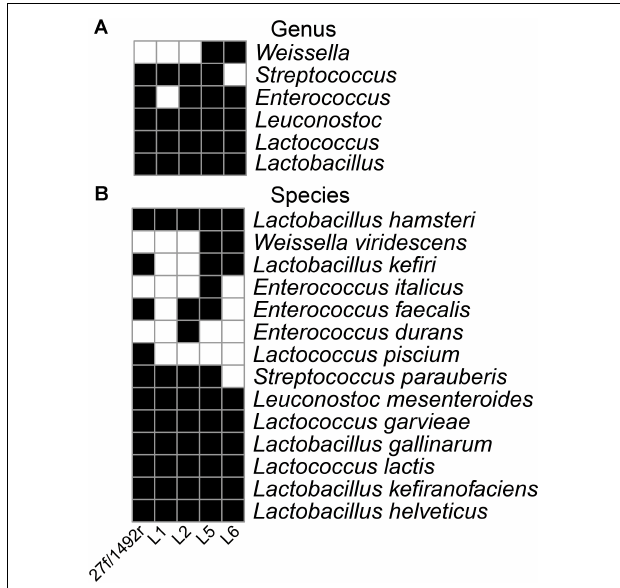
FIGURE 1 | Diversity of LAB in a koumiss sample identified using various primers. A koumiss sample with a high relative abundance of LAB was evaluated using SMRT sequencing of amplicons. A heatmap was created according to the presence (black squares) and absence (white squares) of the target bacteria at the genus (A) and species (B) level.